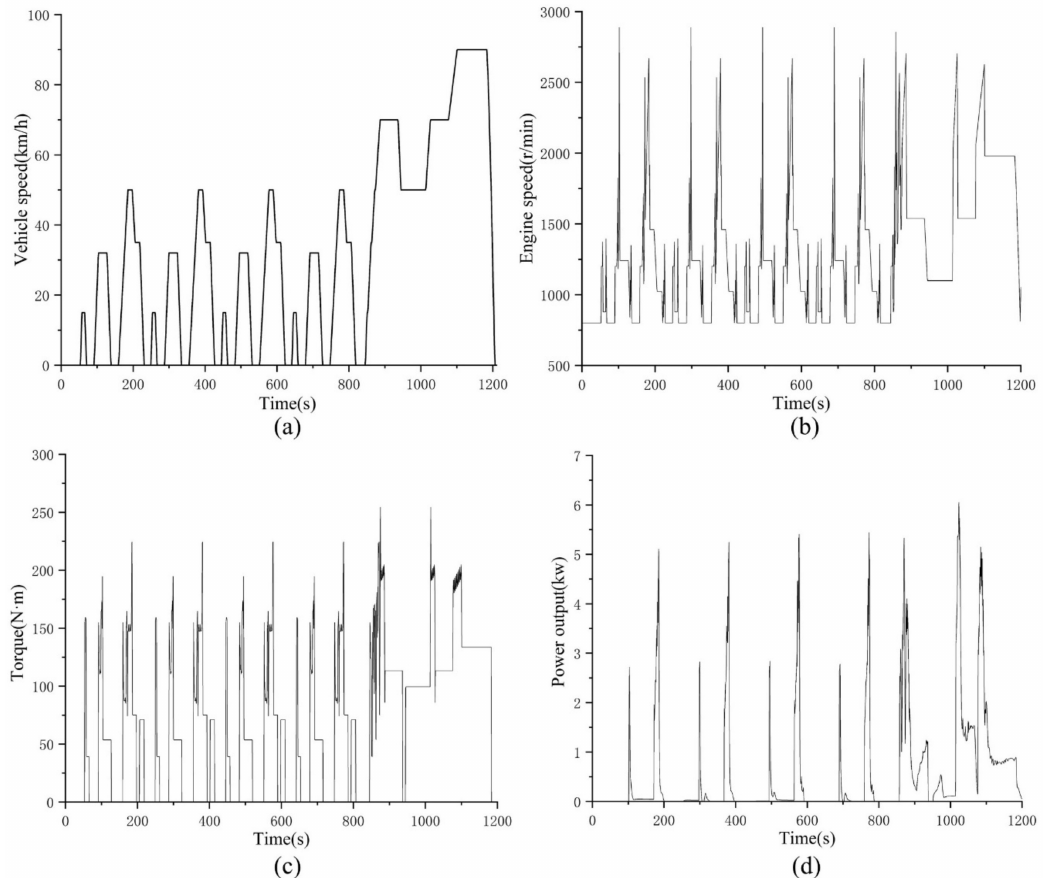
Figure 11. Results for the transient simulation of the ICE-ORC combined system: ( a ) The vehicle speed, ( b ) the engine speed, ( c ) the engine torque, and ( d ) the expander power